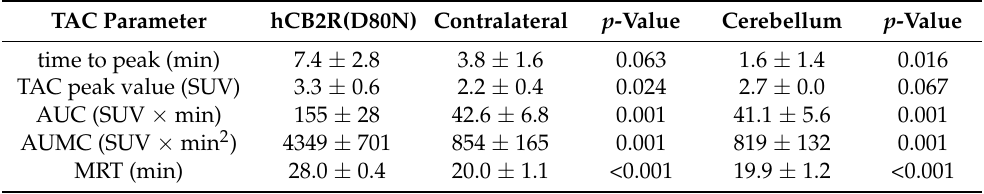
Table 2. Uptake of [ 18 F] LU14 into the hCB2R overexpressing right striatum normalised to the contralateral contralateral site or cerebellum with ( n = 2) or without ( n = 3) displacement by i.v. injected GW405833 (5 mg/kg bodyweight) at 20 min after radiotracer administration expressed as area under the curve before (AUC 0–20min ) and after (AUC 20–60min ) injection of the interventional drug. Treatment (5 mg/kg AUC 0–20min (CI 95% ) AUC 40–60min (CI 95% ) hCB2R D80N-to- GW405833, i.v.) in SUVr × min in SUVr × min vehicle 210 (190 to 231) (10 min pior tracer) contralateral displacement (20 min after tracer) − 73.4% vehicle 215 (190 to 241) (10 min prior tracer) cerebellum displacement 51 (42 to 60) − 76.3% (20 min after tracer) Mean; 95% confidence interval (CI 95%